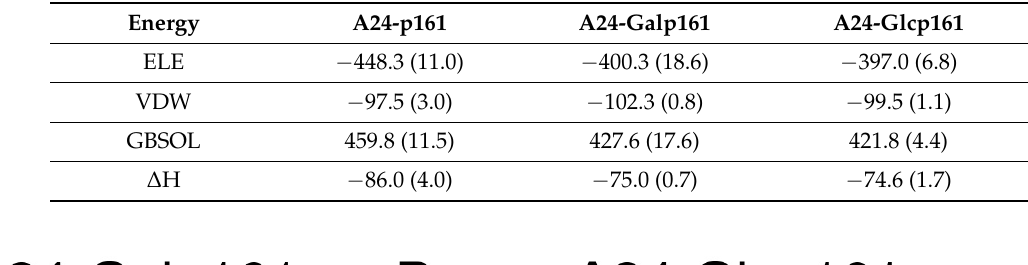
Table 3. Binding energies ∆ H GBSA between the p161 peptides and A24 during the 300–500 ns phase of the MD simulations with the standard deviations in parentheses.